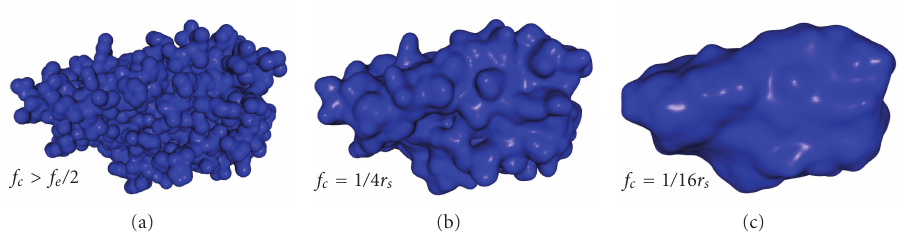
f c = 1 / 16 r s (shape approximation) is shown in Figure